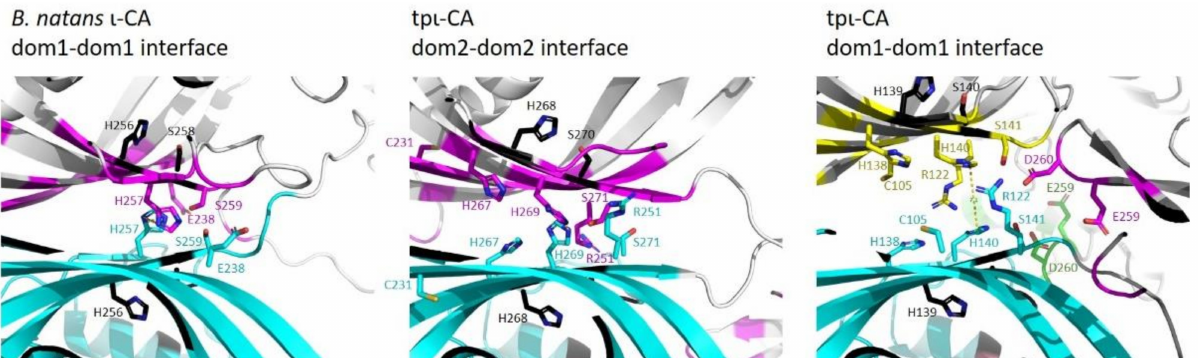
Figure 8. Structure of the ι -CA β -sandwich interface between the domain 1s of B. natans ι -CA (pdb 7C5X), between domains 2 and 1 of tp ι -CA. The monomer A is colored blue, and the residues within 5 Å of the monomer A are colored magenta for those of monomer B, green for those of monomer C and yellow for those of monomer D. The distance between His257 residues in B. natans ι -CA is 4.5 Å, between His269 residues in the domains 2 of tp ι -CA is 3.5 Å and between His 140 in the domains 1 of tp ι -CA is 7.1